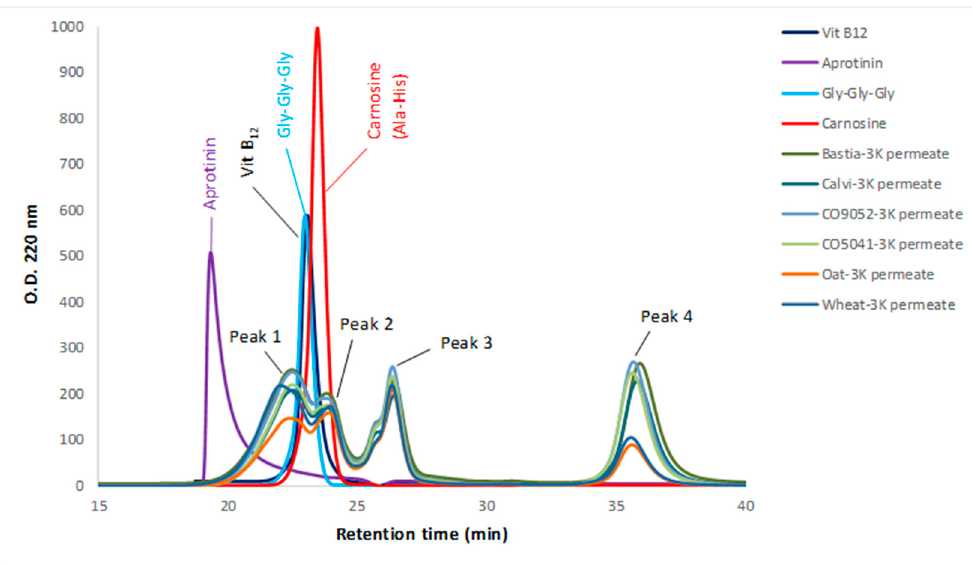
Figure 1. Size-exclusion HPLC profile of canary seed, oat and wheat 3K permeates prepared by subjecting sample flours to in vitro gastrointestinal digestion followed by 3-kDa molecular weight cutoff (MWCO) ultrafiltration. Peaks 1, 2, 3 and 4 represent resolved polypeptides eluted at different retention times than eluted peptides standard named aprotinin, Vit B12, Gly–Gly–Gly and carnosine.